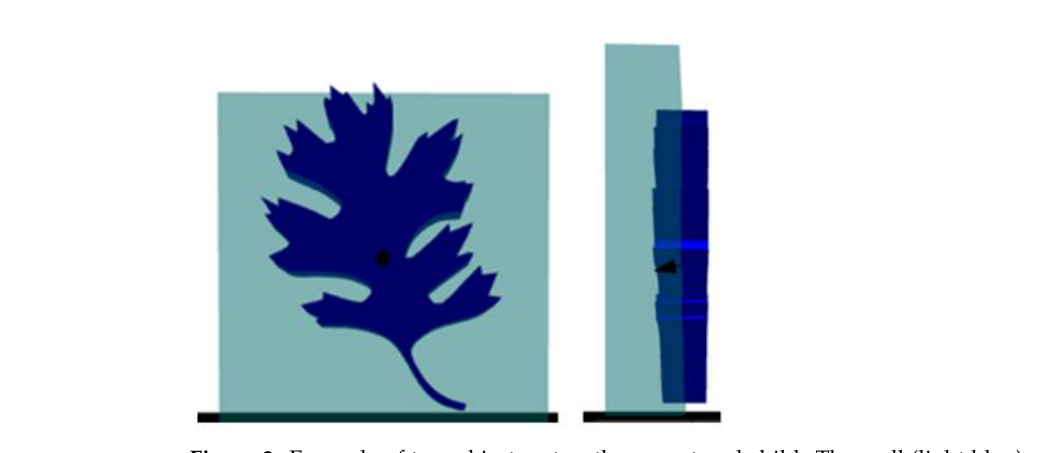
Figure 2. Example of two objects set as the parent and child. The wall (light blue) represents the parent, while the oak leaf (dark blue) represents the child.